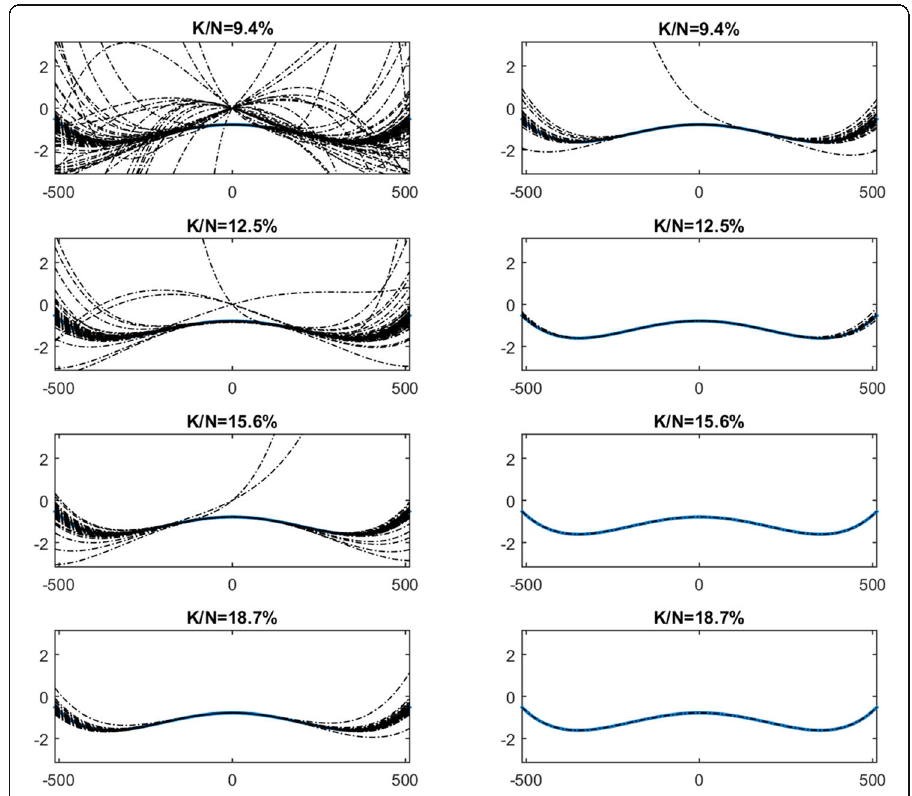
Fig. 6 Fifth-order PPS — 100 trials of the RANSAC procedure without (left) and with refinement (right column) for various K / N : first row — 7.8%; second row — 9.4%; third row — 12.5%; fourth row — 15.6%. Blue line — exact IF values; black lines —